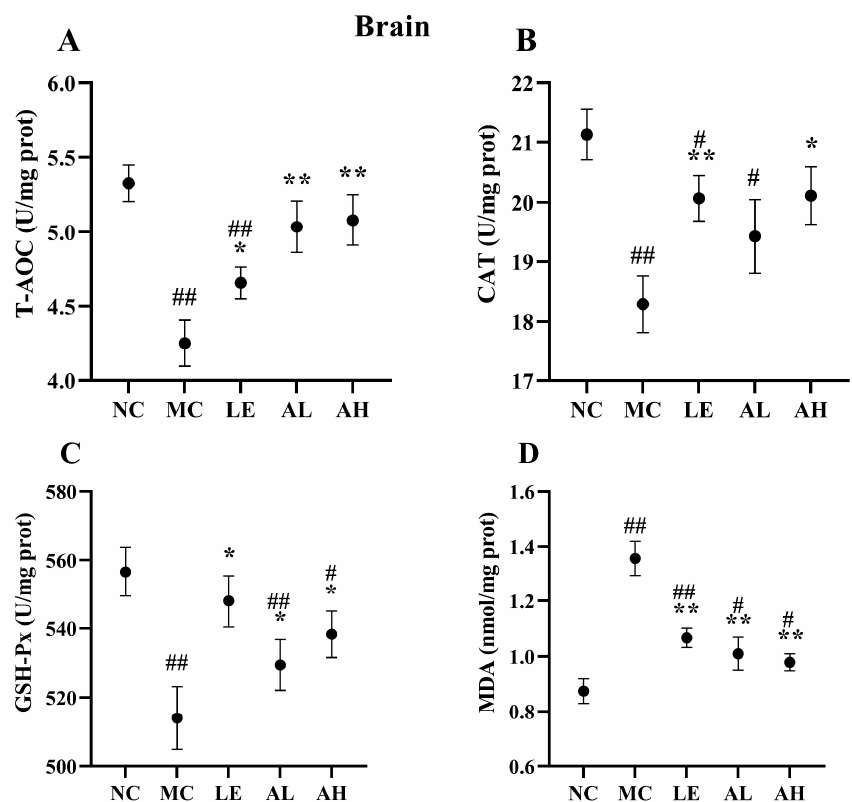
Figure 5. Effects of AAPS on the antioxidant capacity in brain of mice ( n = 10 per group). ( A ) T-AOC. ( B ) CAT. ( C ) GSH-Px. ( D ) MDA. LE, 300 mg/kg.bw/d Lentinan; AL, 300 mg/kg.bw/d AAPS; AH, 600mg/kg.bw/d AAPS. Data are presented as the means ± SEM. # p < 0.05, ## p < 0.01 vs. NC